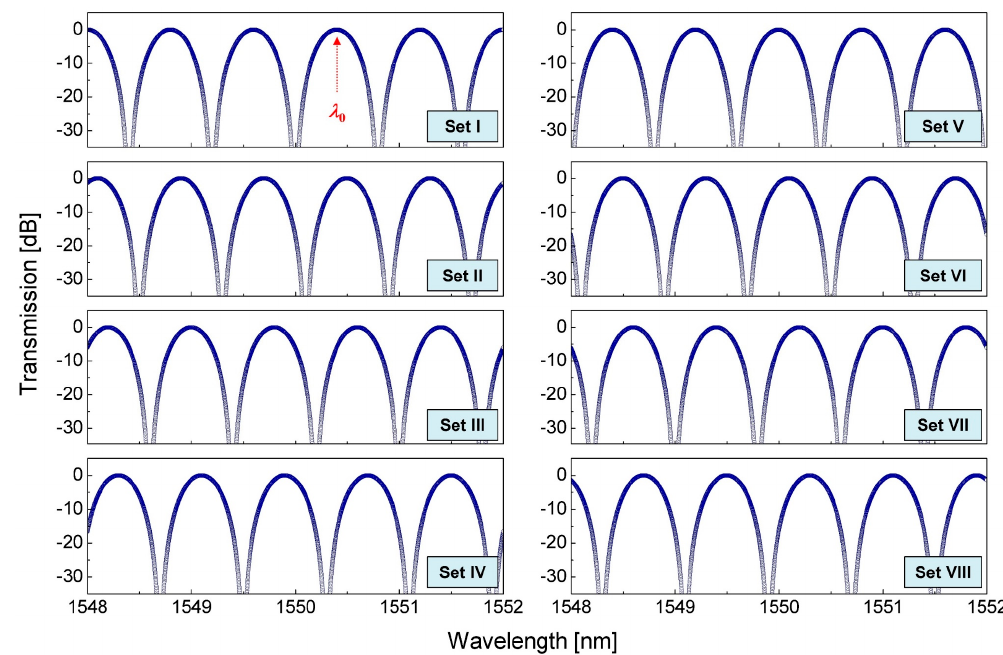
Figure 3. Calculated narrowband transmission spectra of the proposed filter, obtained at the eight selected four AOA (FAOA) sets (sets I to VIII) shown in Figure 2 over the wavelength range from 1548 to 1552 nm.